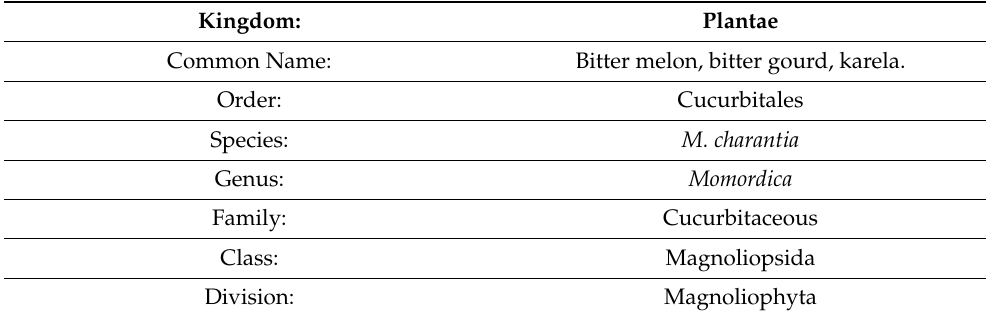
Table 1. Classification of M. charantia . Kingdom: Plantae Common Name: Bitter melon, bitter gourd, karela. Order: Cucurbitales